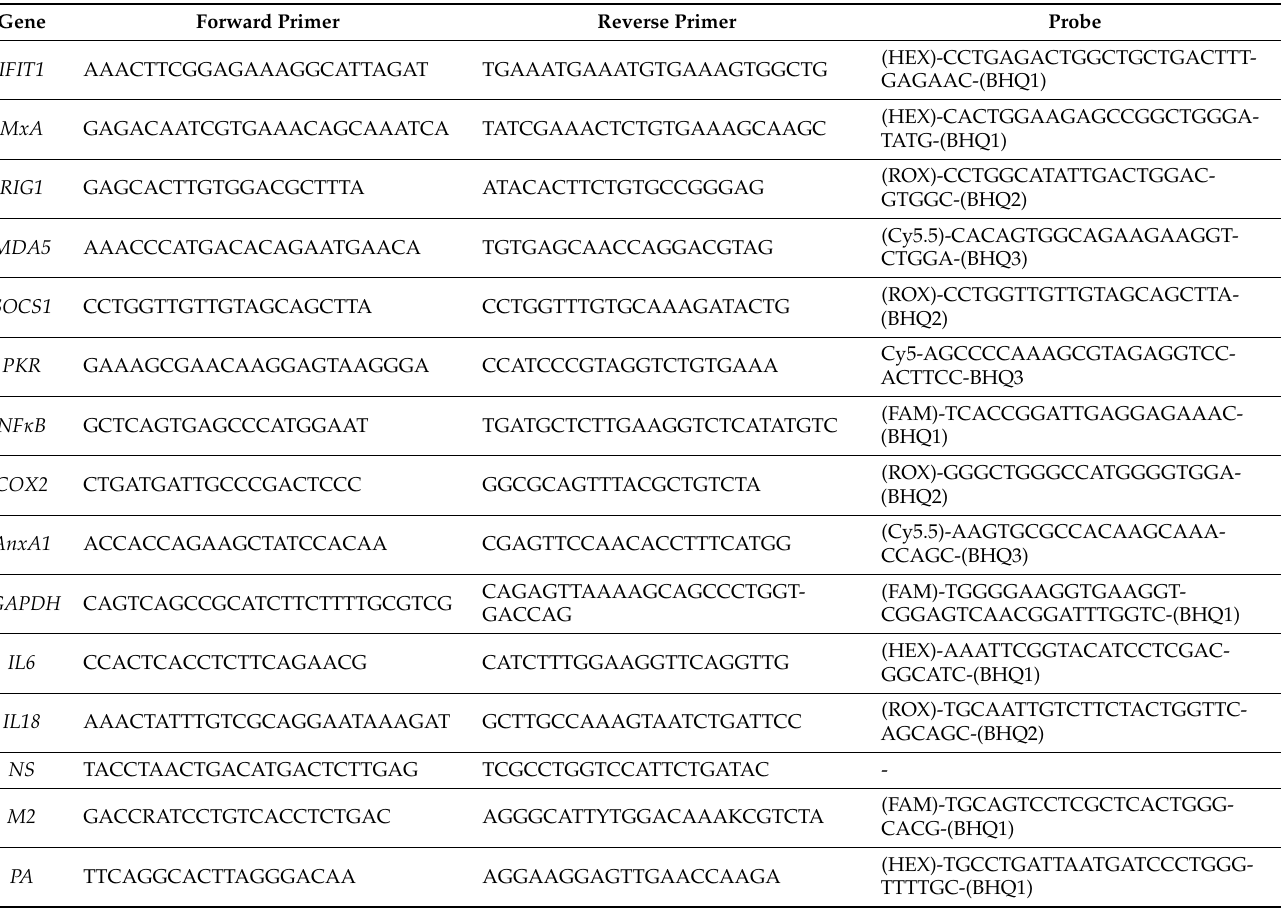
Table 1. Primer and TaqMan probe